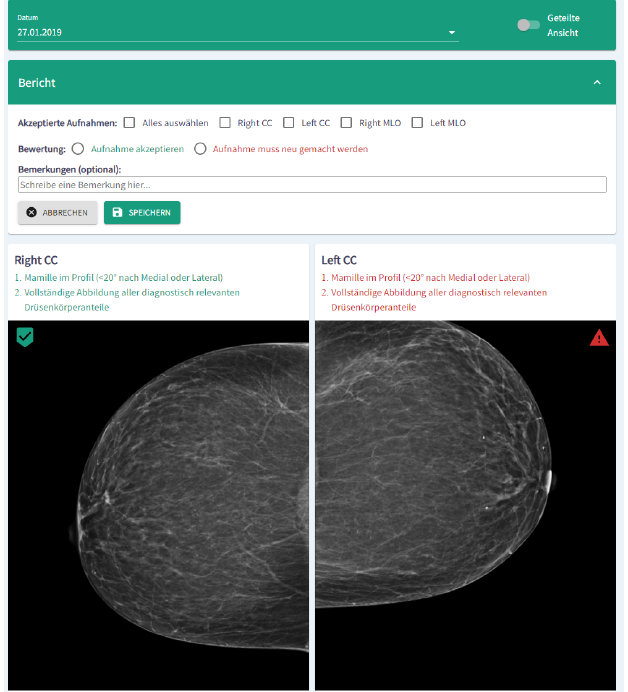
Figure 36. Screenshot (cutout) of the module visualization. In the upper part of the module, images can be accepted or rejected, whereas in the lower part the results of the algorithms are